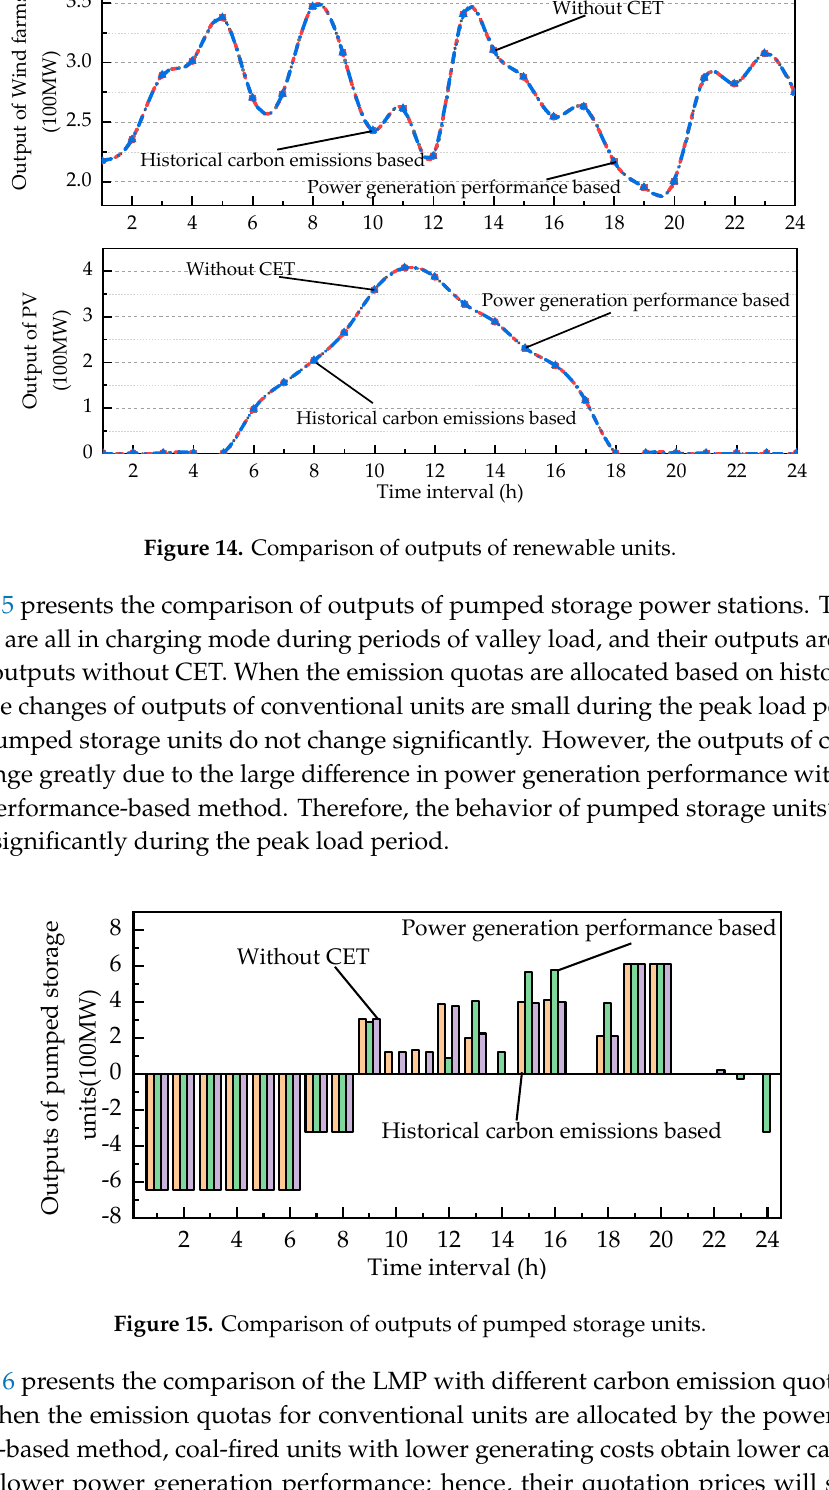
Figure 13. Comparison of outputs of gas-fired units.